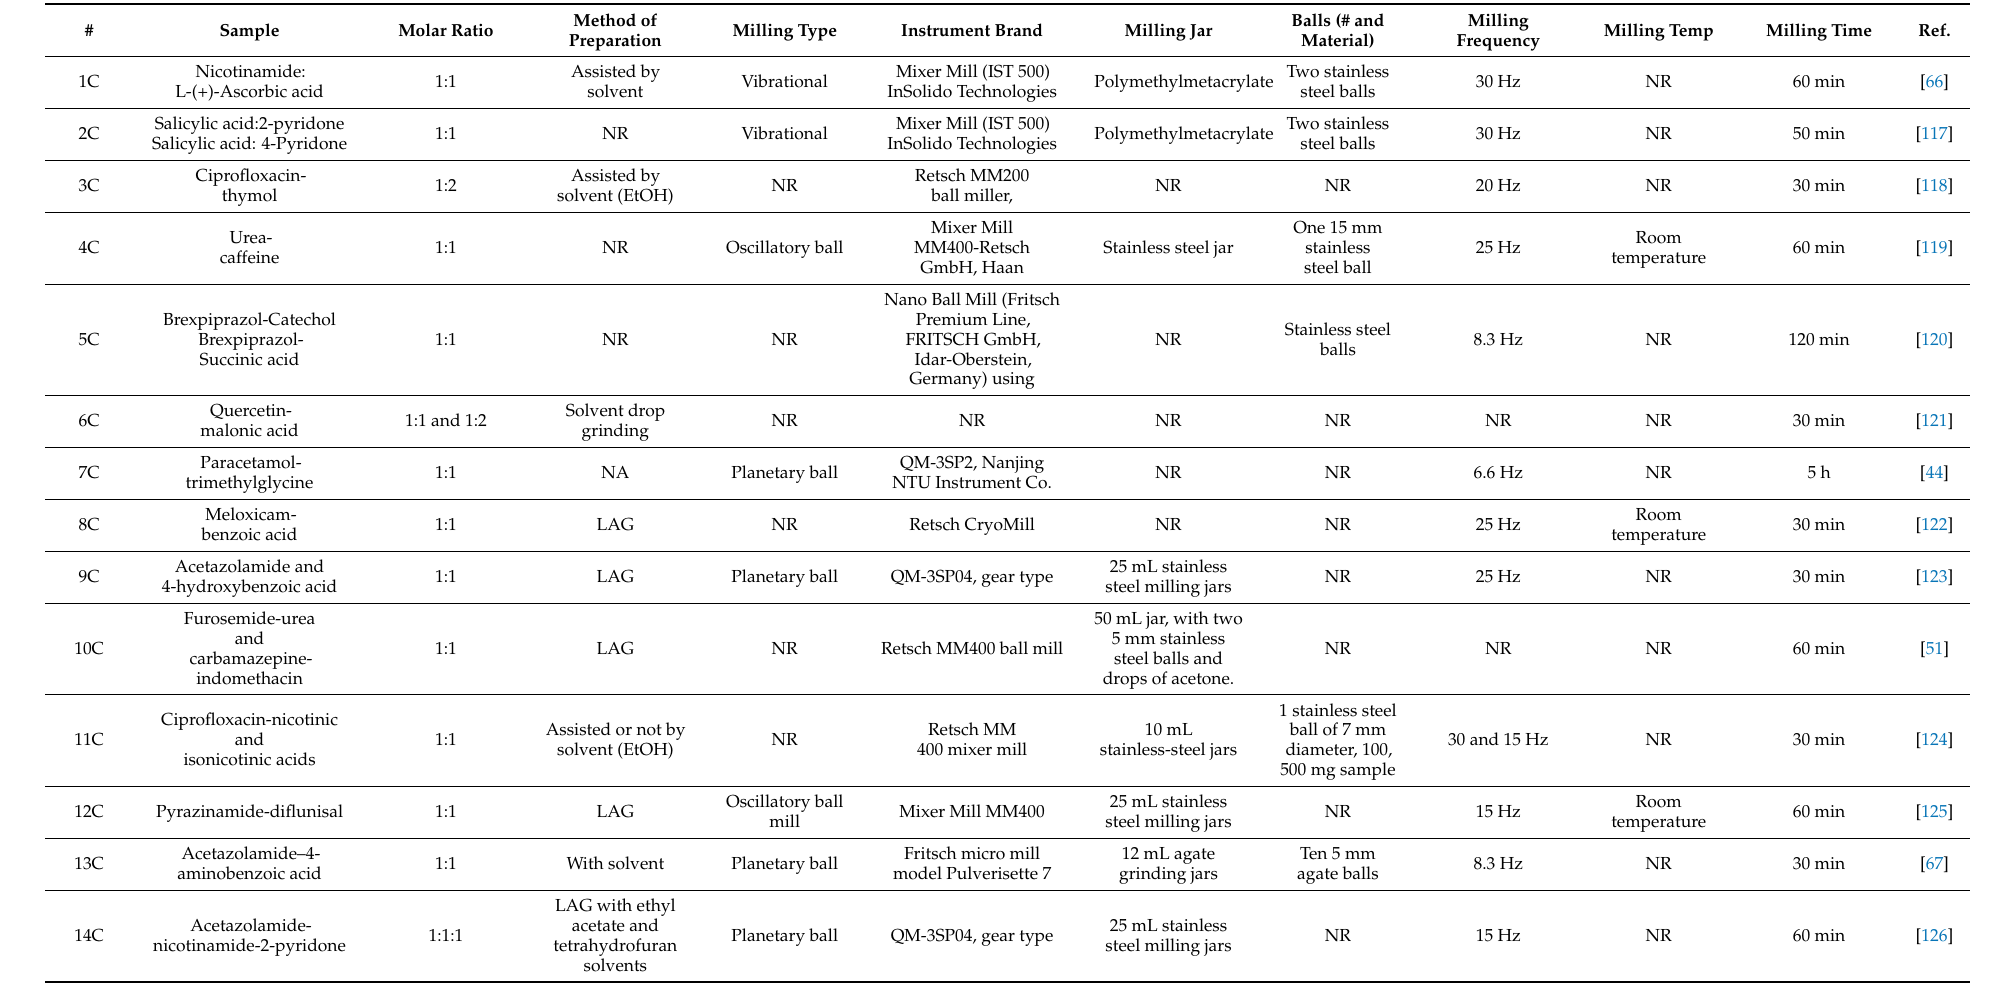
Table 2. Conditions of preparation of co-crystals by grinding